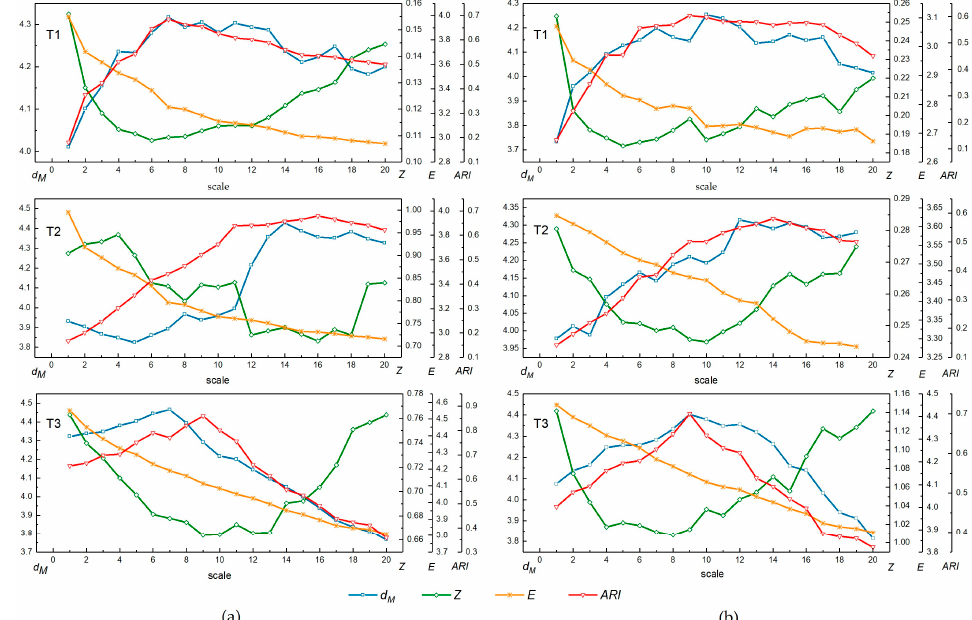
Figure 10. Comparing the d M method with existing evaluation methods ( Z , E and ARI) for testing images T1, T2, and T3: ( a ) plots of evaluation methods for MRS with different scale parameters; and ( b ) plots of evaluation methods for MSS with different scale parameters.